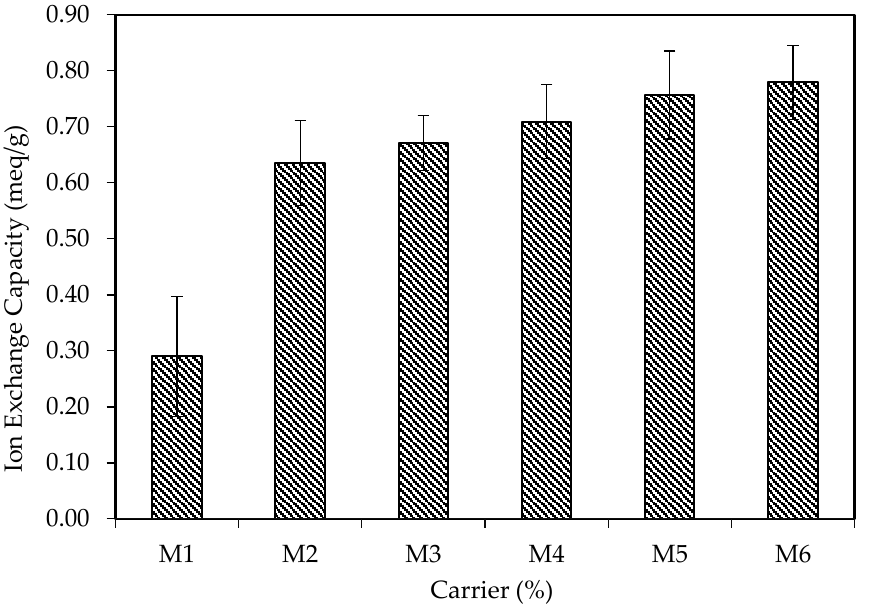
Figure 12. Ion exchange capacity (IEC) of M1, M2, M3, M4, M5 and M6.